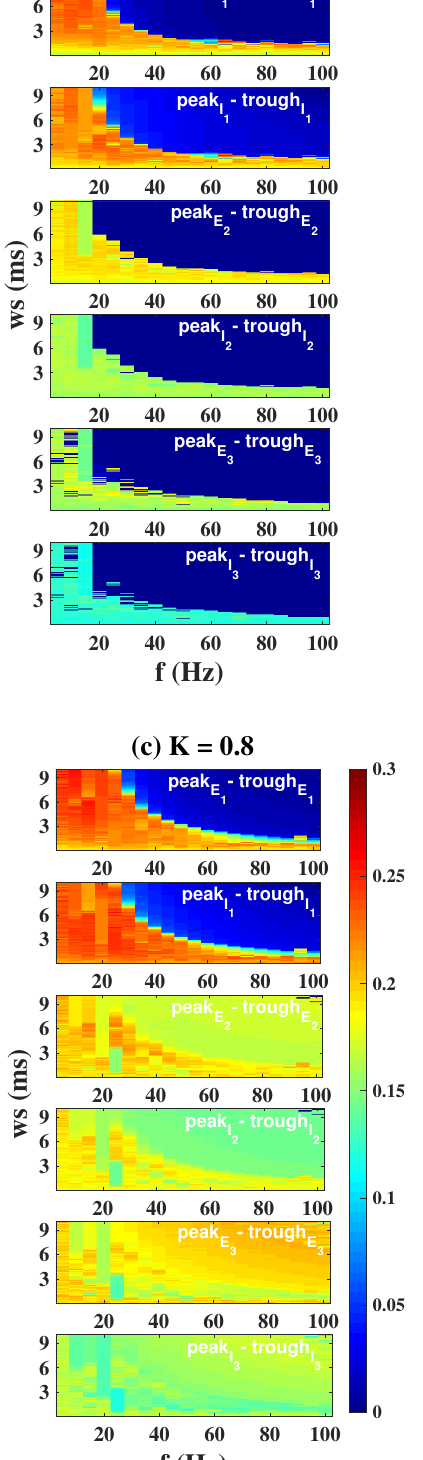
Figure 11. Dynamical responses of the three columns when OS targets I 1 . The control effect of column2 and column3 is closely related to K. Three compartments can be controlled well when K = 0.31 ( a ). The controllable areas of column2 and column3 are reduced ( K = 0.52, ( b )), even to zero ( K = 0.8, ( c